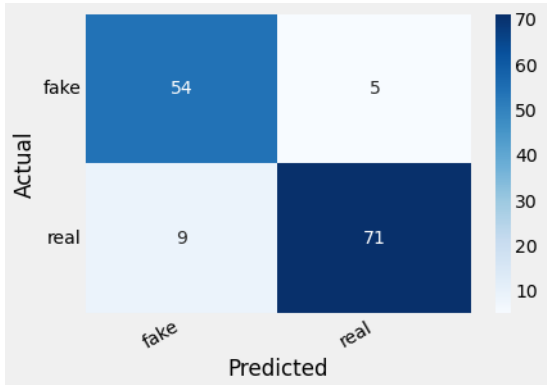
Figure 14. Confusion matrix of BERT base -CNN-BiGRU in PolitiFact w/o user posting behavior